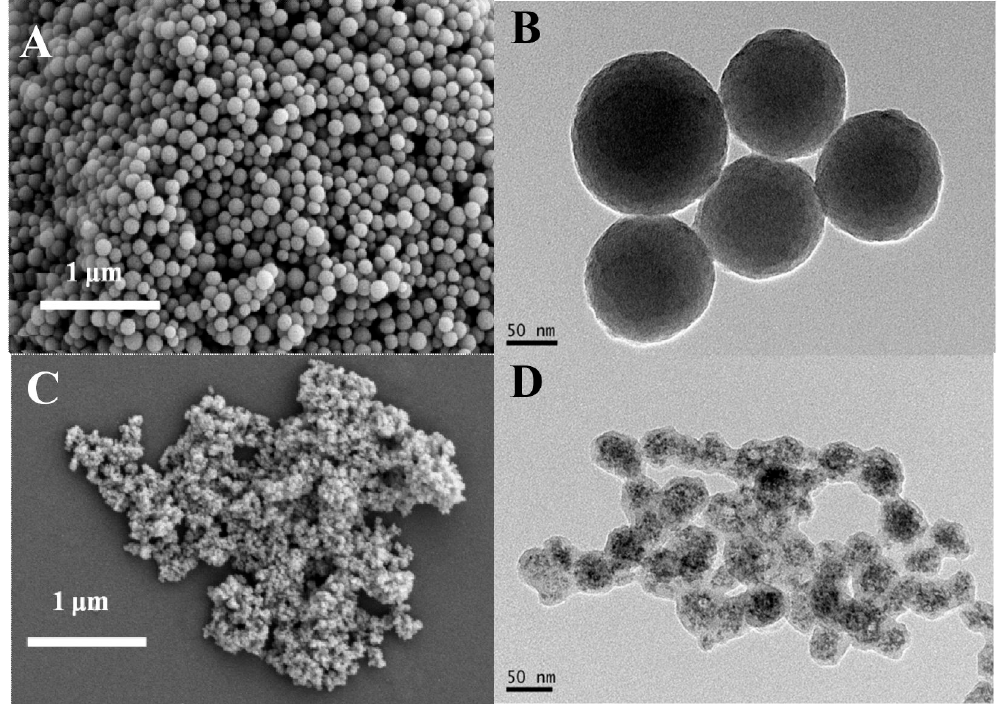
Figure 2. SEM and TEM images of ( A , B ) carbonaceous spheres; ( C , D ) CeCO 3 OH@C.